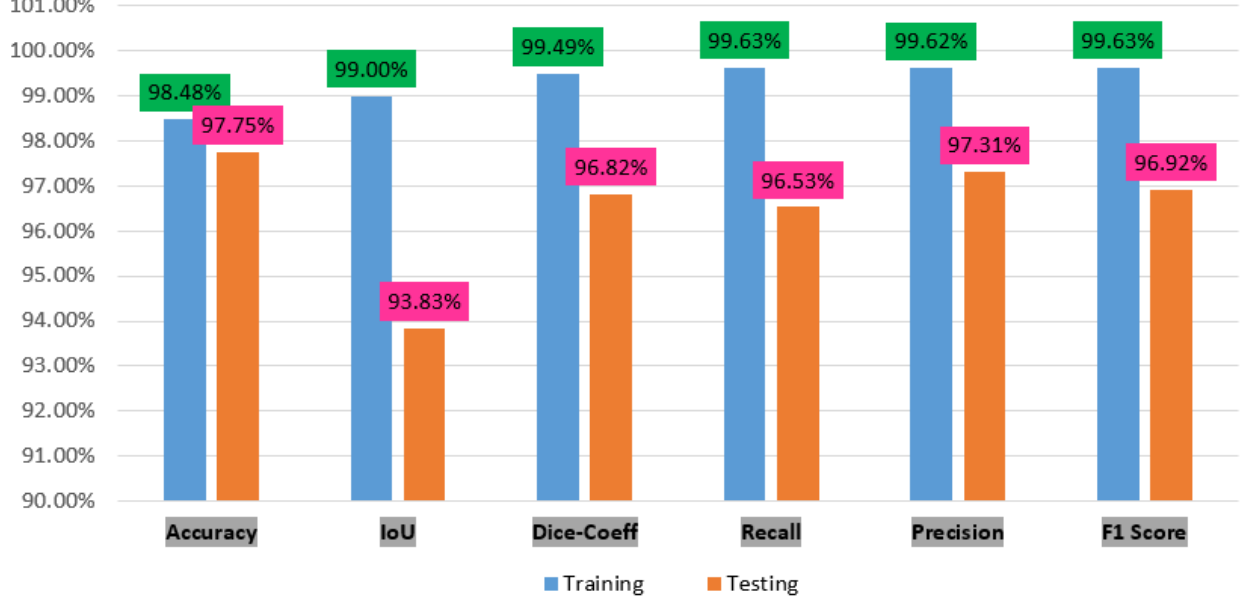
Figure 8. The performance charts of accuracy, IoU, dice_coeff, recall, precision and F1 score.